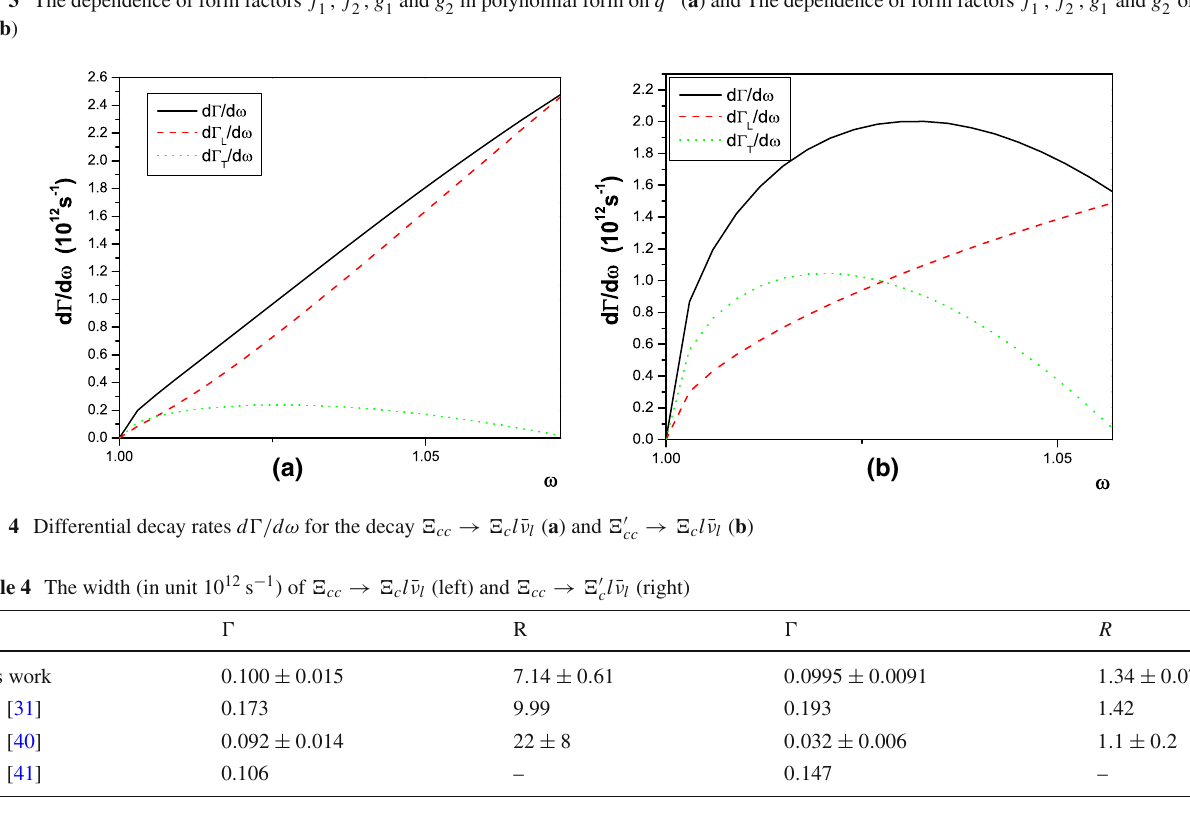
Fig. 3 The dependence of form factors f s